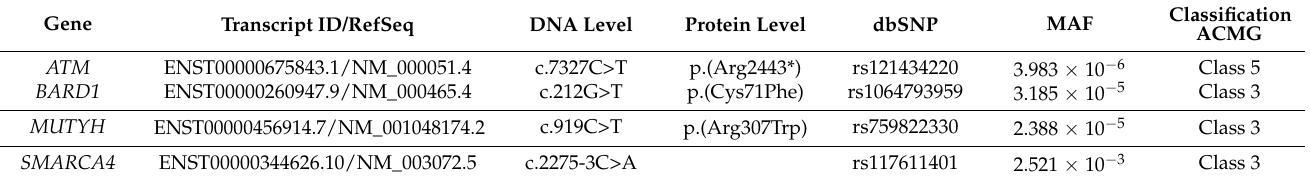
Table 3. Identified DNA variants as a result of the extended genetic analysis